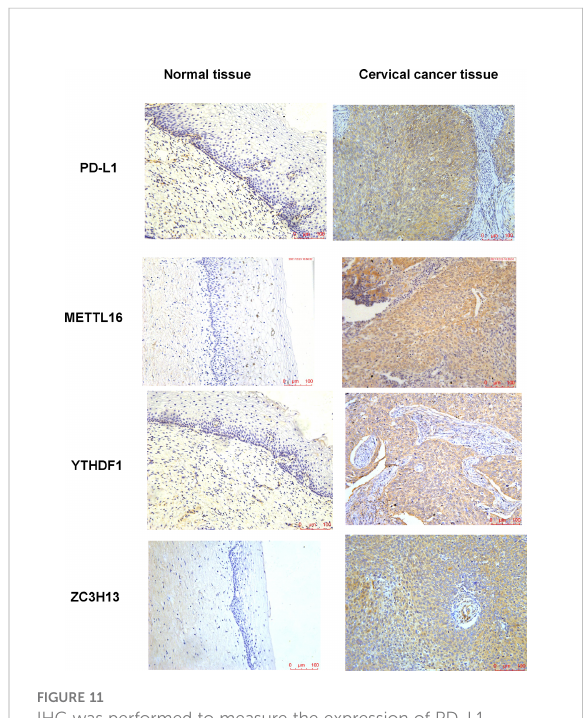
FIGURE 11 IHC was performed to measure the expression of PD-L1, METTL16, YTHDF1, and ZC3H13 in cervical cancer tissues and surrounding normal